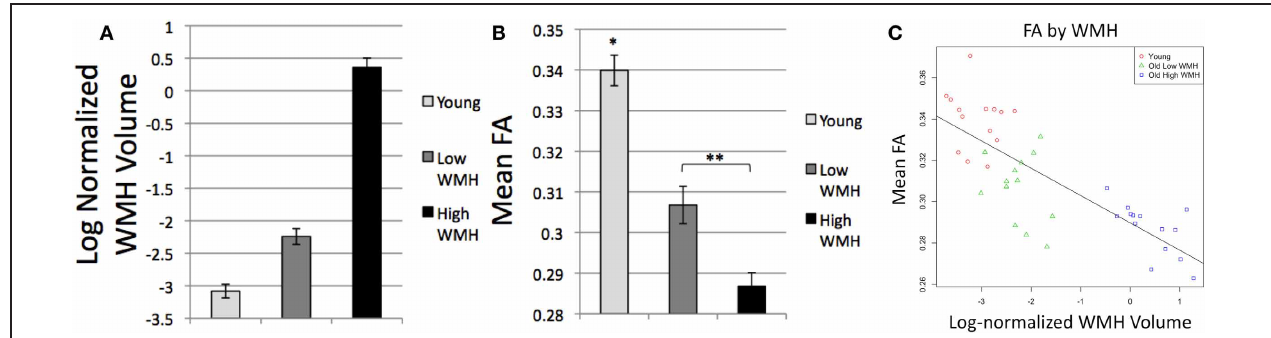
FIGURE 2 | (A) Global log-normalized WMH volume by group, all groups differ p < 0 . 0001; (B) Mean global white matter FA by group, ∗ Differs from all groups, p < 0 . 0001, ∗∗ Groups differ, p = 0.002; (C) Mean global white matter FA by log-normalized WMH volume.